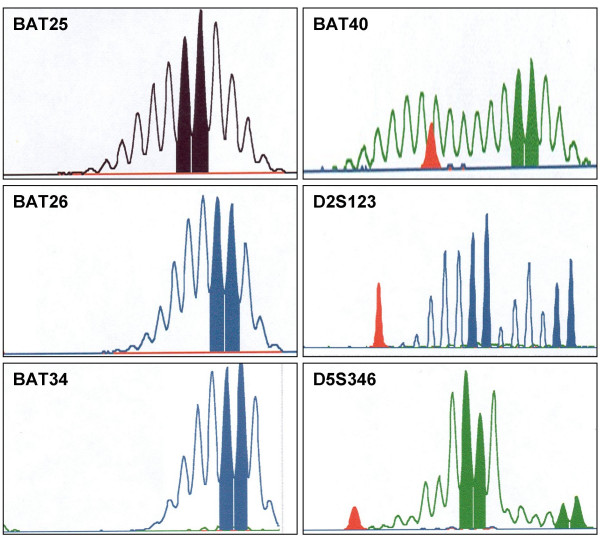
Microsatellite instability in case RP8-626 where the MSI-curves show instability with 1–2 additional peaks for the markers BAT25, BAT26 and BAT34 and larger size variation for the markers BAT40, D2S123 and D5S346.